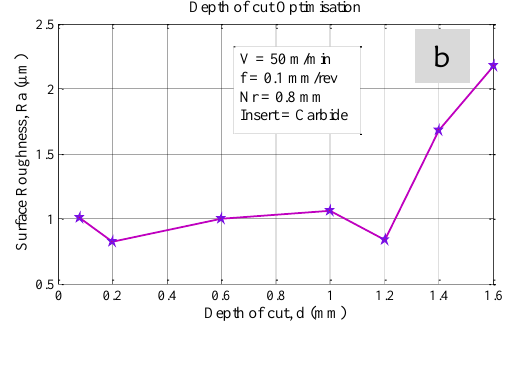
Figure 7: The trend of average surface roughness (Ra) with depth of cut (d) for constant feed rate (0.1